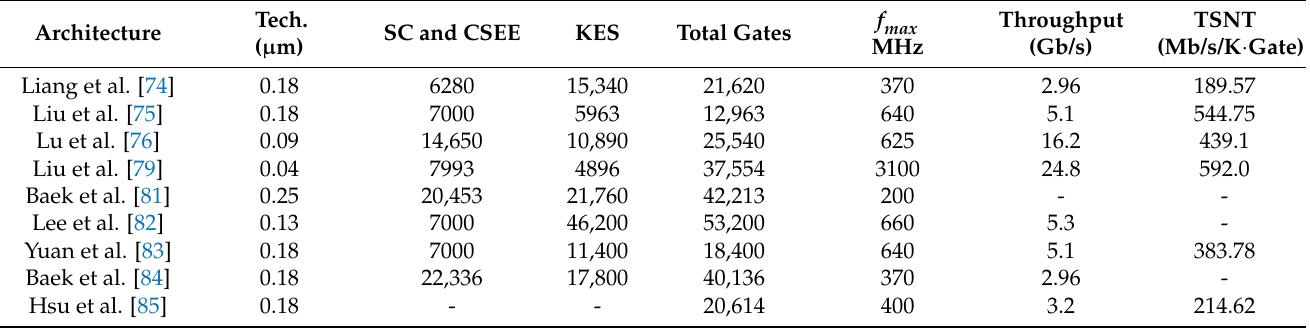
Table 5. Performance summary of recently proposed RS decoders for the UWB physical